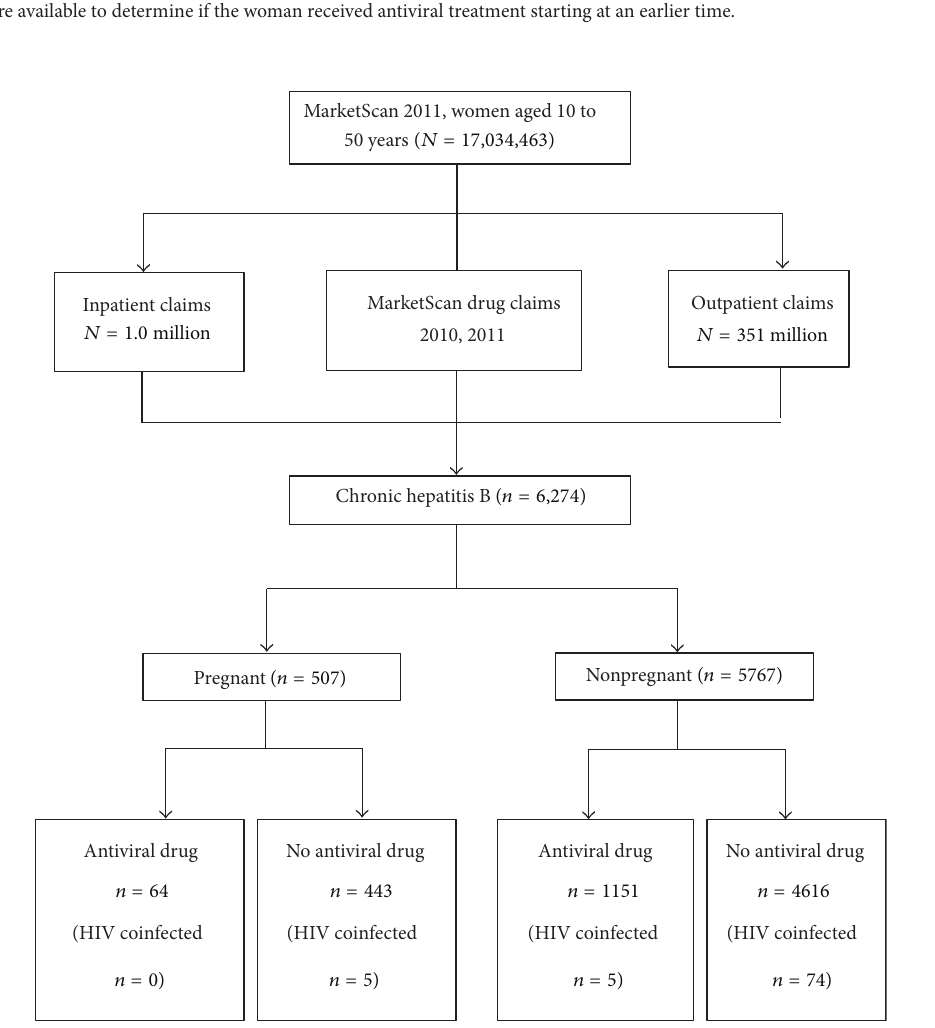
Figure 1: Selection of